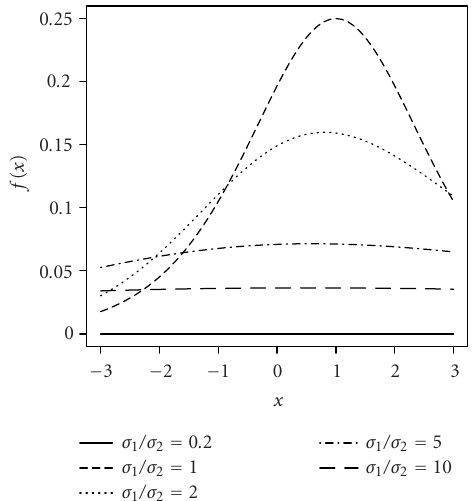
Figure 2.2. The generalized logistic pdf (2.3) for σ 1 /σ 2 = 0 . 2,1,2,5,10, σ 2 = 1, µ 1 = 1, and µ 2 =